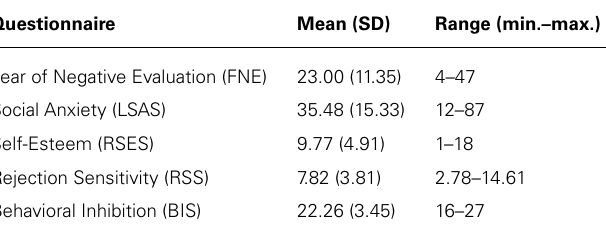
Table 1 | Means, standard deviations (SD) and range (minimum– maximum) of the scores on the self-reported questionnaires.